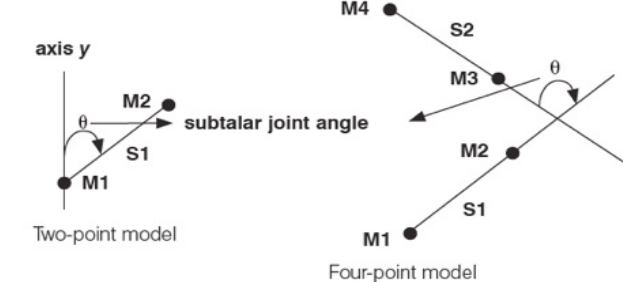
Figure 2 – Mathematical models of two and four points for calculation of subtalar pronation [ 2 ] .